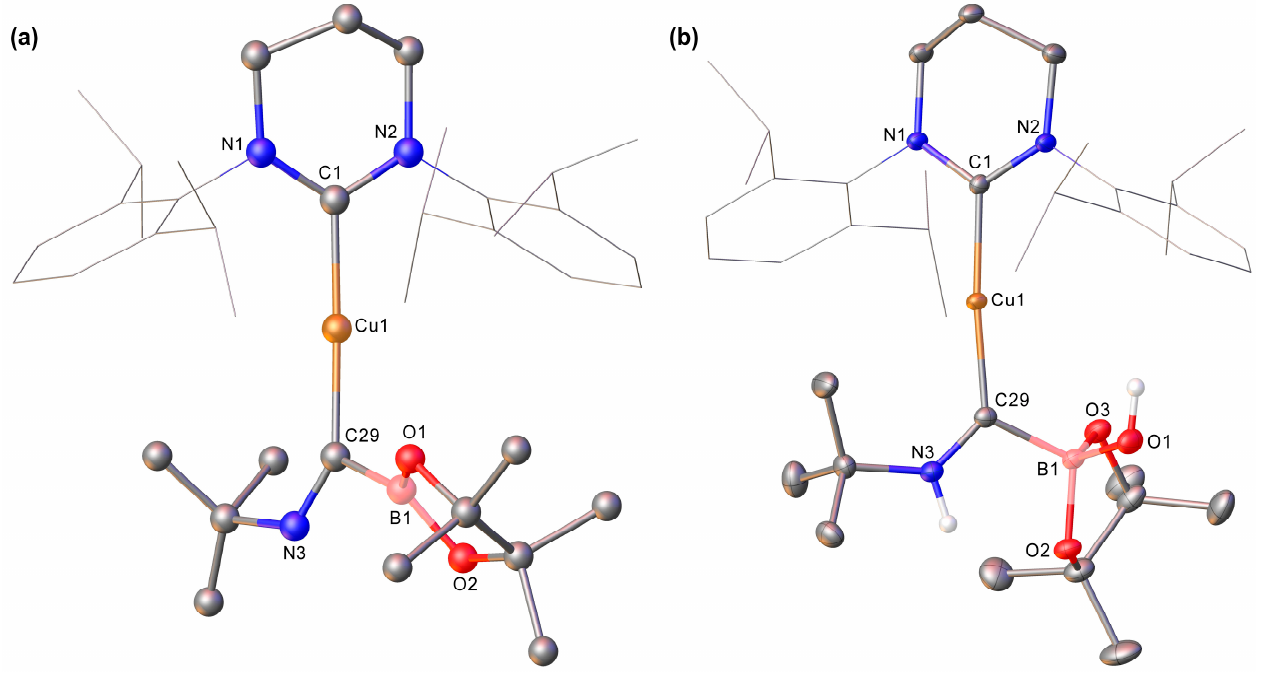
Figure 1. ( a ) Ball and stick drawing arising from a preliminary structural determination of 1 (for additional information regarding the limitations of this diffraction experiment, see ESI). ( b ) Crystal structure of 1 ·H 2 O (30% probability ellipsoids) where lattice solvent and hydrogen atoms (except for those bonded to O1 and N3) have been omitted for visual clarity. Wireframe view has been employed for Dipp groups, also for visual simplicity. Selected bond lengths (Å), angles (°), and geometric parameters: ( a ) C1-Cu1 1.934(7); Cu1-C29 1.937(9); C29-B1 1.59(2); C29-N3 1.265(14); N1-C1-